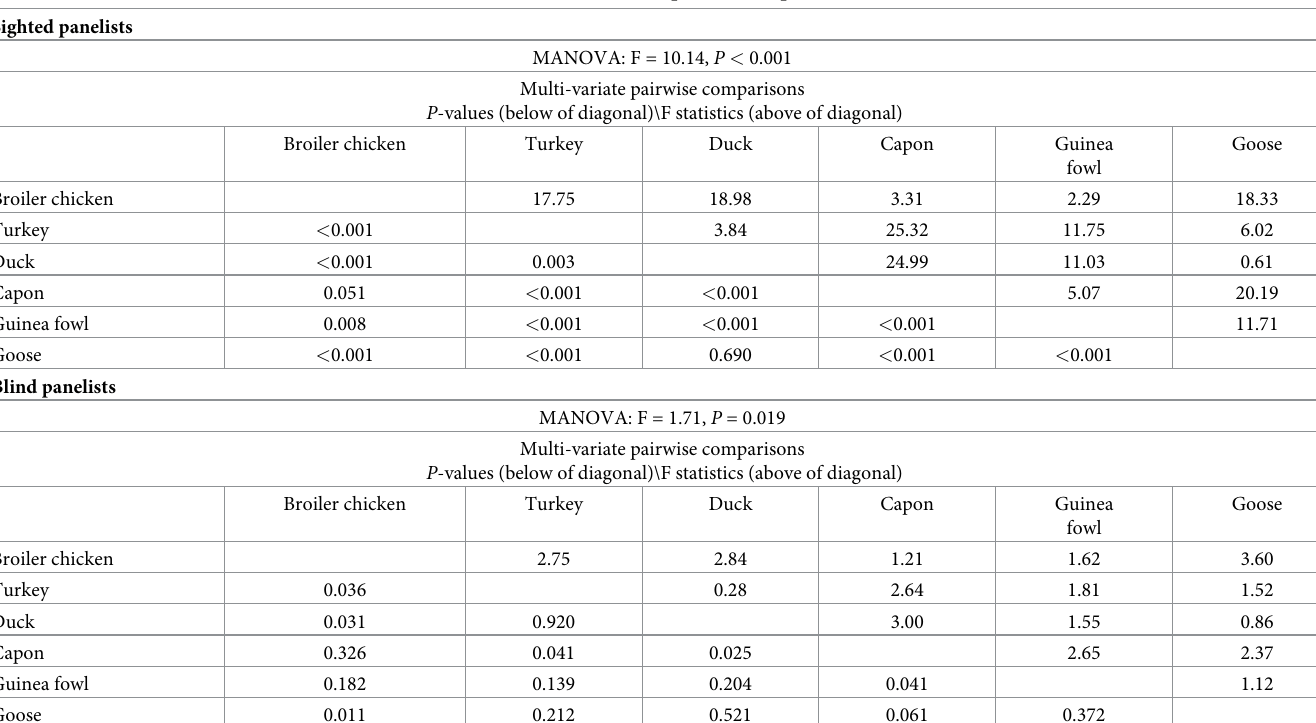
Broiler chicken Turkey Duck 0.031 Capon 0.326 Guinea fowl 0.182 Goose